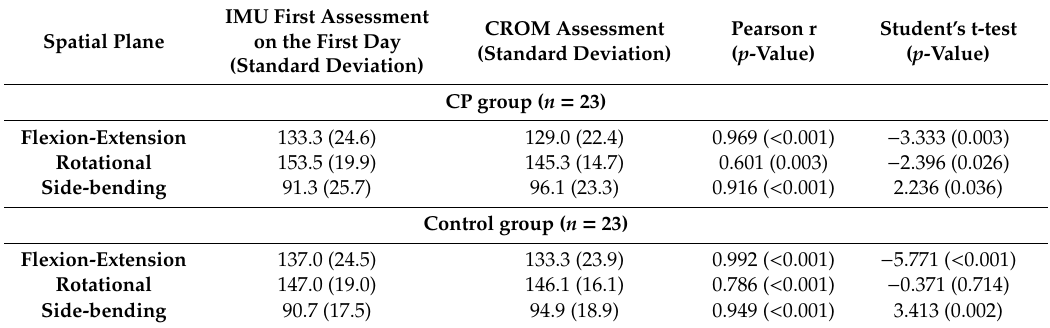
Table 2. Concurrent validity between the first IMU assessment performed on the first day of measurements and CROM by